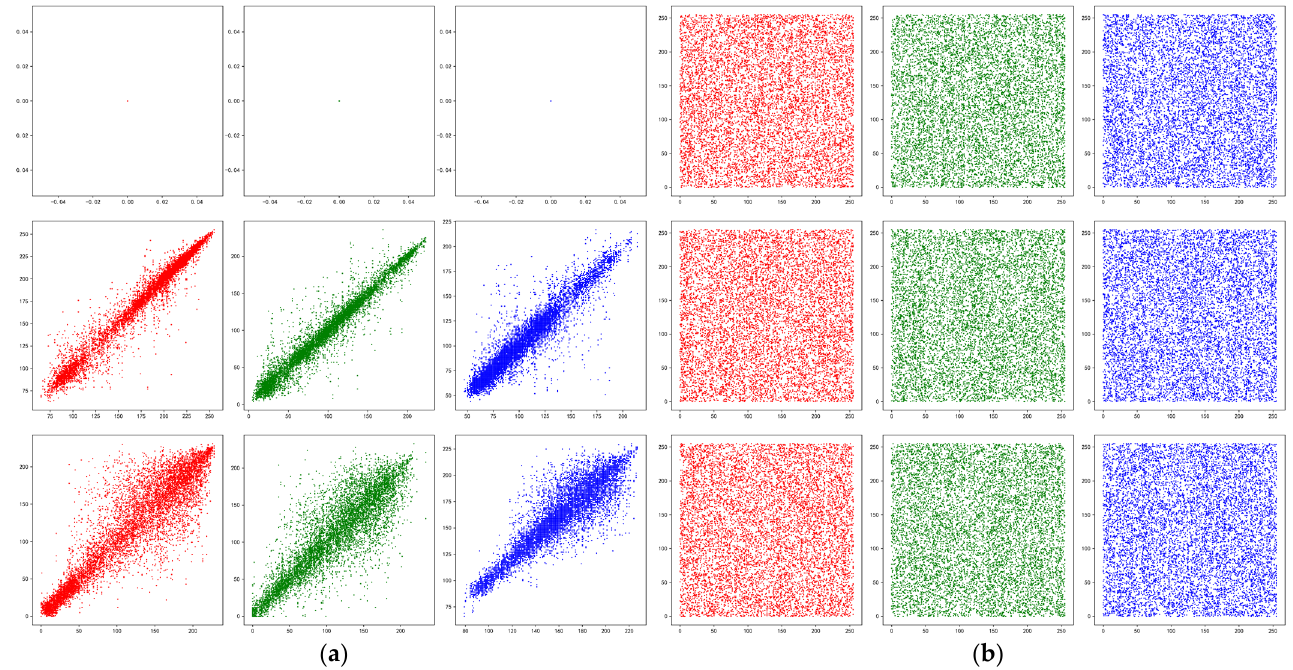
15 of 21 Table 3. Three-channel correlation comparison between experimental image and cipher image. Test Image